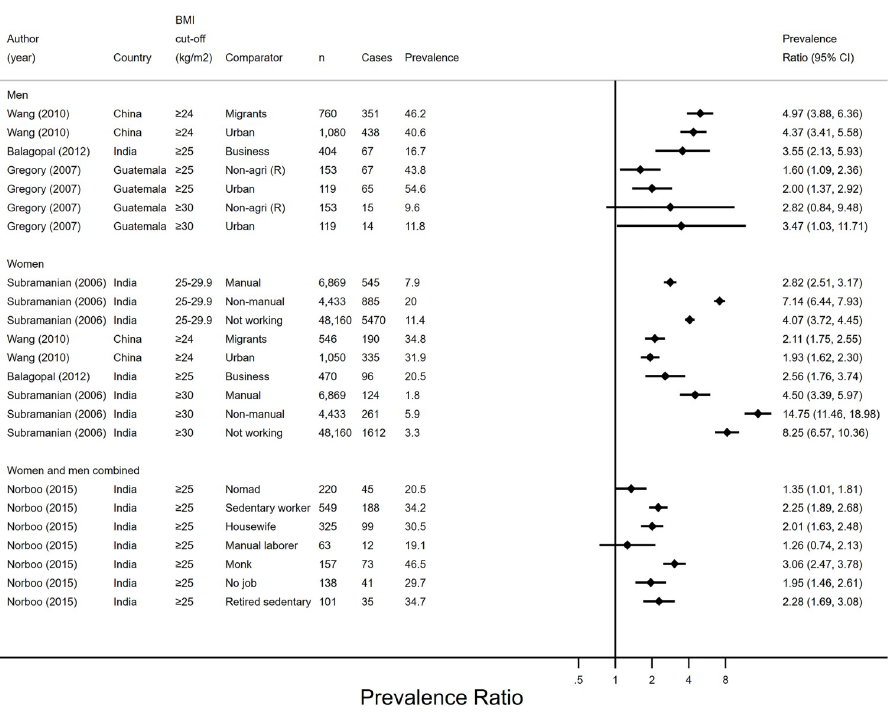
Fig 3. Prevalence ratios and 95% confidence intervals of overweight and obesity by employment status (n = 5). Agri–agriculture, BMI–body mass index, CI–confidence interval, n–sample size, PR–prevalence ratio; R–rural. Prevalence ratios were derived from comparing each non-agricultural group (coded 1) to the agricultural group (coded